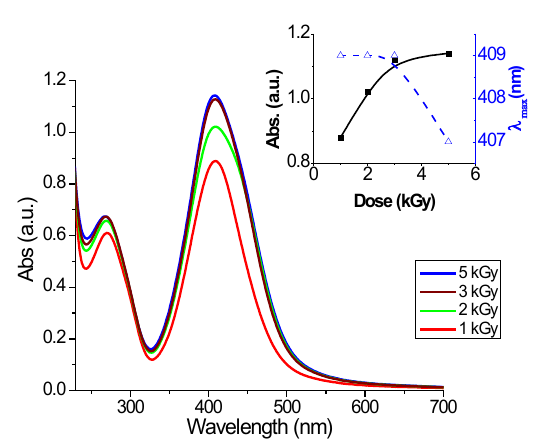
Figure 5. The UV-VIS spectra for the samples obtained by irradiation at low dose rate and IPA-TA composition. Inset: the effect of radiation dose on the absorption peak characteristics.